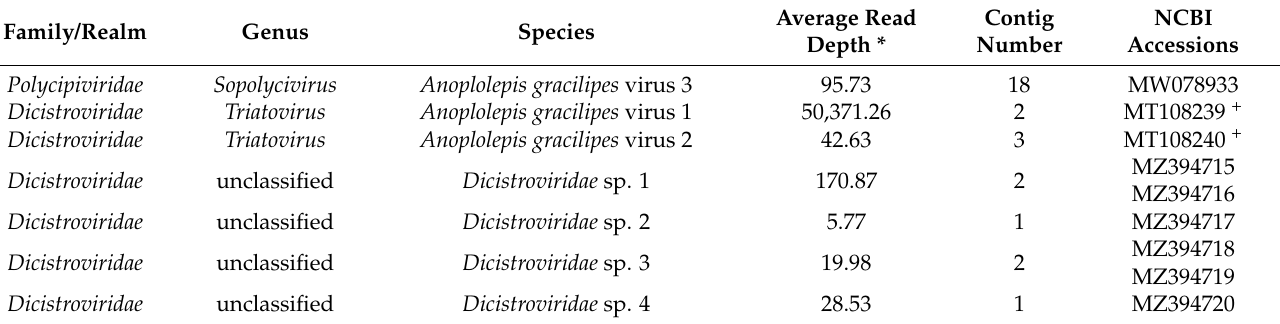
Table 1. Single-stranded RNA viruses and virus-like fragments discovered in A . gracilipes